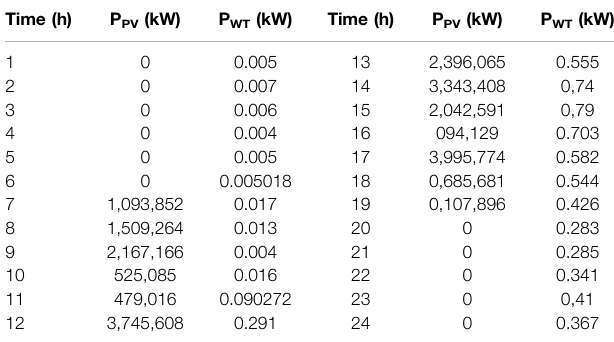
TABLE 6| Renewable generators generate optimal power and express by P WT ( t ) and P PV ( t ) .